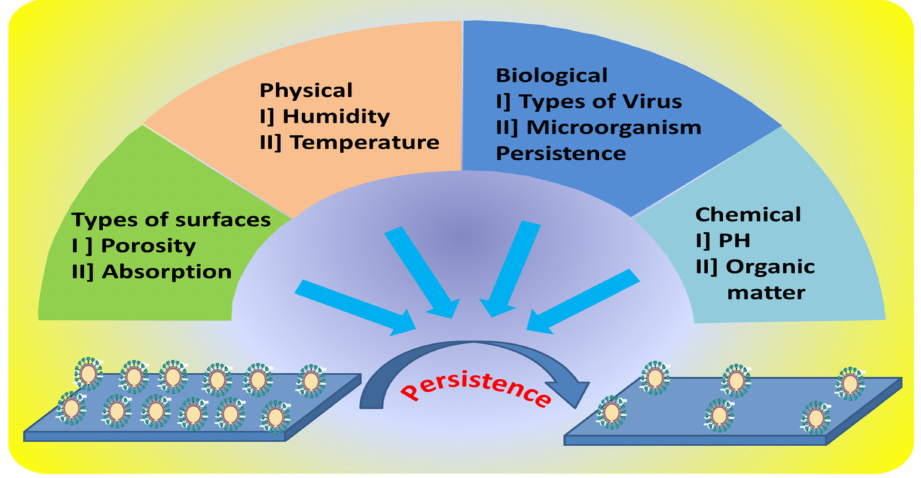
Figure 2. Surface properties influencing the persistence of